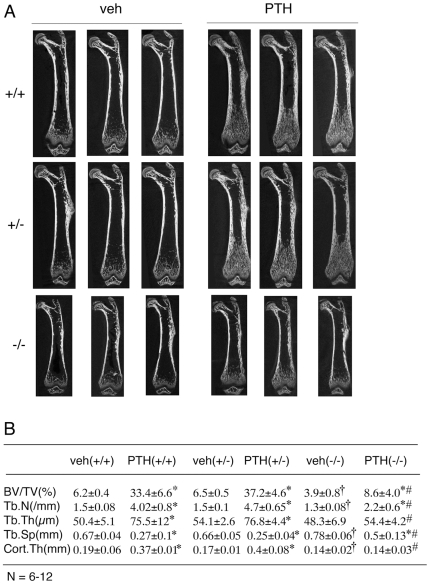
PTH-stimulated bone was significantly reduced or lost in Atf4−/− femurs.A, two-dimensional (2D) reconstruction from μCT scan of femurs from growing wt, Atf4+/− and Atf4−/− mice treated with and without intermittent PTH for 28 d. B, quantitative analysis of bone volume/tissue volume (BV/TV), trabecular number (Tb. N), trabecular thickness (Tb.Th), trabecular space (Tb.Sp), and cortical thickness (Cort. Th). *P<0.05 (veh vs. PTH), † P<0.05 (wt-veh vs. Atf4−/−-veh), #P<0.05 (PTH/veh-wt vs. PTH/veh-Atf4−/−).